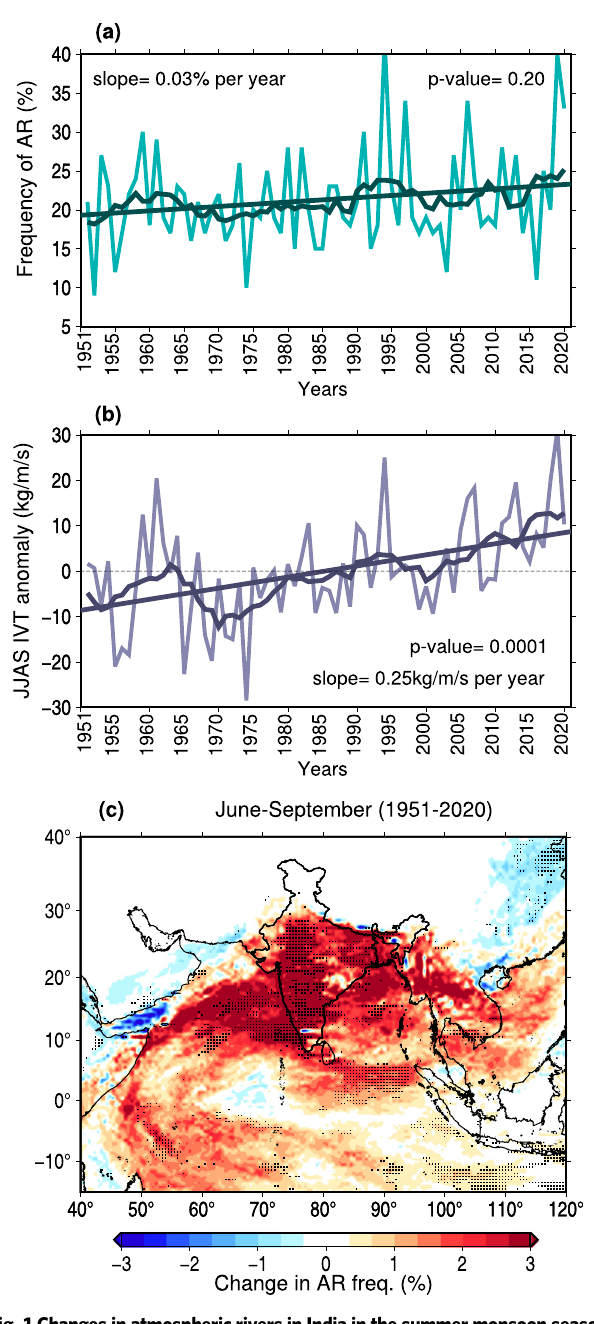
Fig. 1 Changes in atmospheric rivers in India in the summer monsoon season (JJAS, June-September) during 1951 – 2020. a Trend in the frequency of occurrence of ARs (%) during 1951 – 2020; b Trend in the summer monsoon season IVT anomaly (kg m − 1 s − 1 ). Solid lines in ( a , b ) indicate the linear trend and 10-year moving mean, respectively; c Long-term (1951 – 2020) change in the frequency of ARs in India. Trend and change (trend slope multiplied by duration) were estimated using the non-parametric Mann-Kendall trend test and Sen slope estimator. Statistical signi fi cance was estimated at 5% level, therefore, p <0.05 indicate signi fi cant trend/change. Stippling in ( c ) shows the regions with statistically signi fi cant change in the frequency of